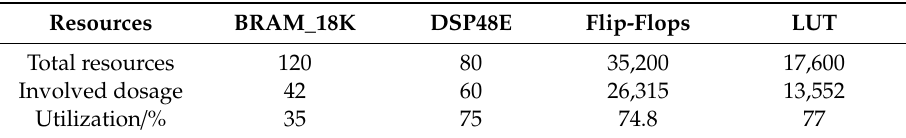
Table 7. SIP test programmable logic resource